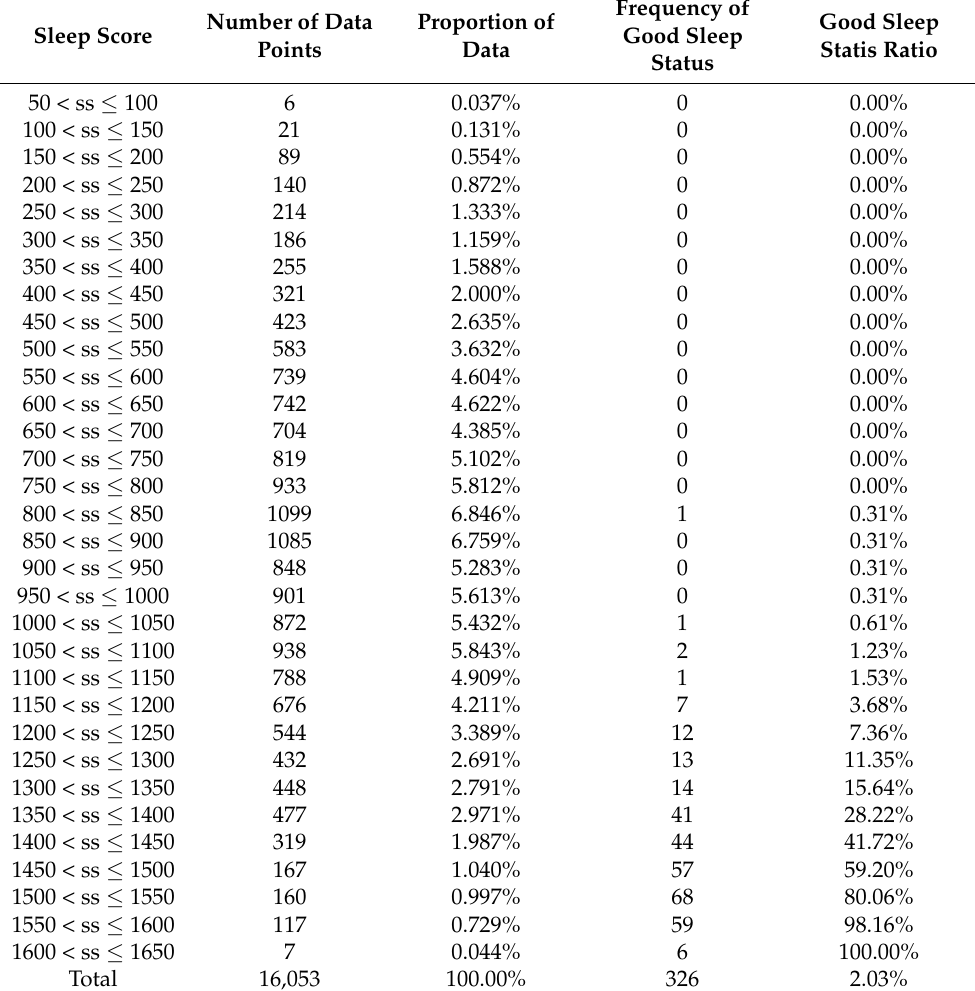
Table 7. Table of data distribution and ratio of good sleep states by